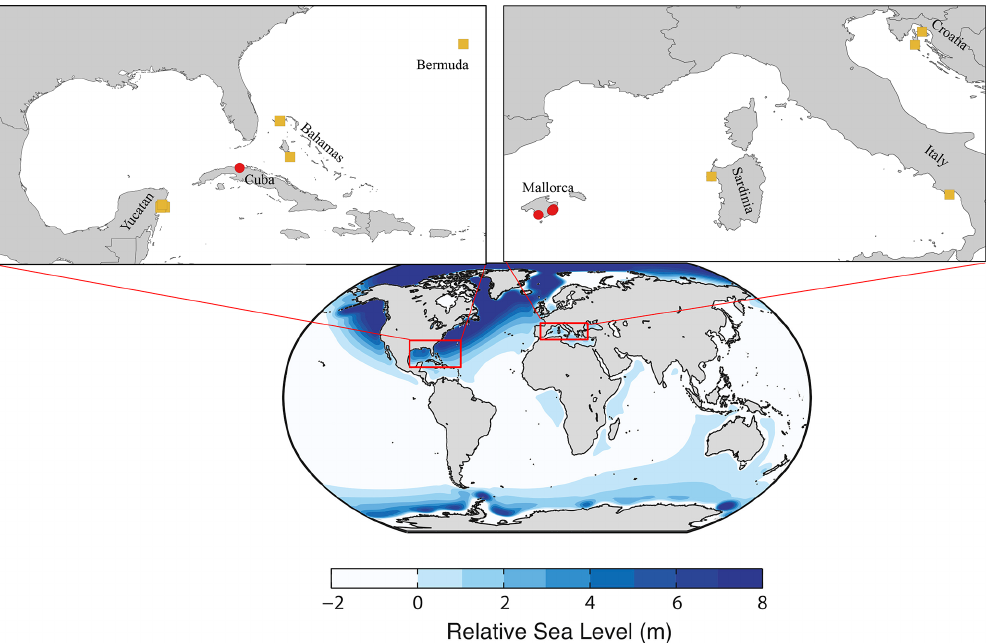
Figure 2. (a) Global map showing the predicted RSL near the end (119ka) of the modeled MIS 5e (see Fig. 2 of paper: https://doi.org/ 10.1016/j.quascirev.2017.06.013; Dendy et al., 2017) to highlight the potential of the samples’ sites to record the behavior of the forebulge during ice-sheet loading and unloading. Sites where POS and SVS were documented and sampled are indicated by red circles and yellow squares, respectively.